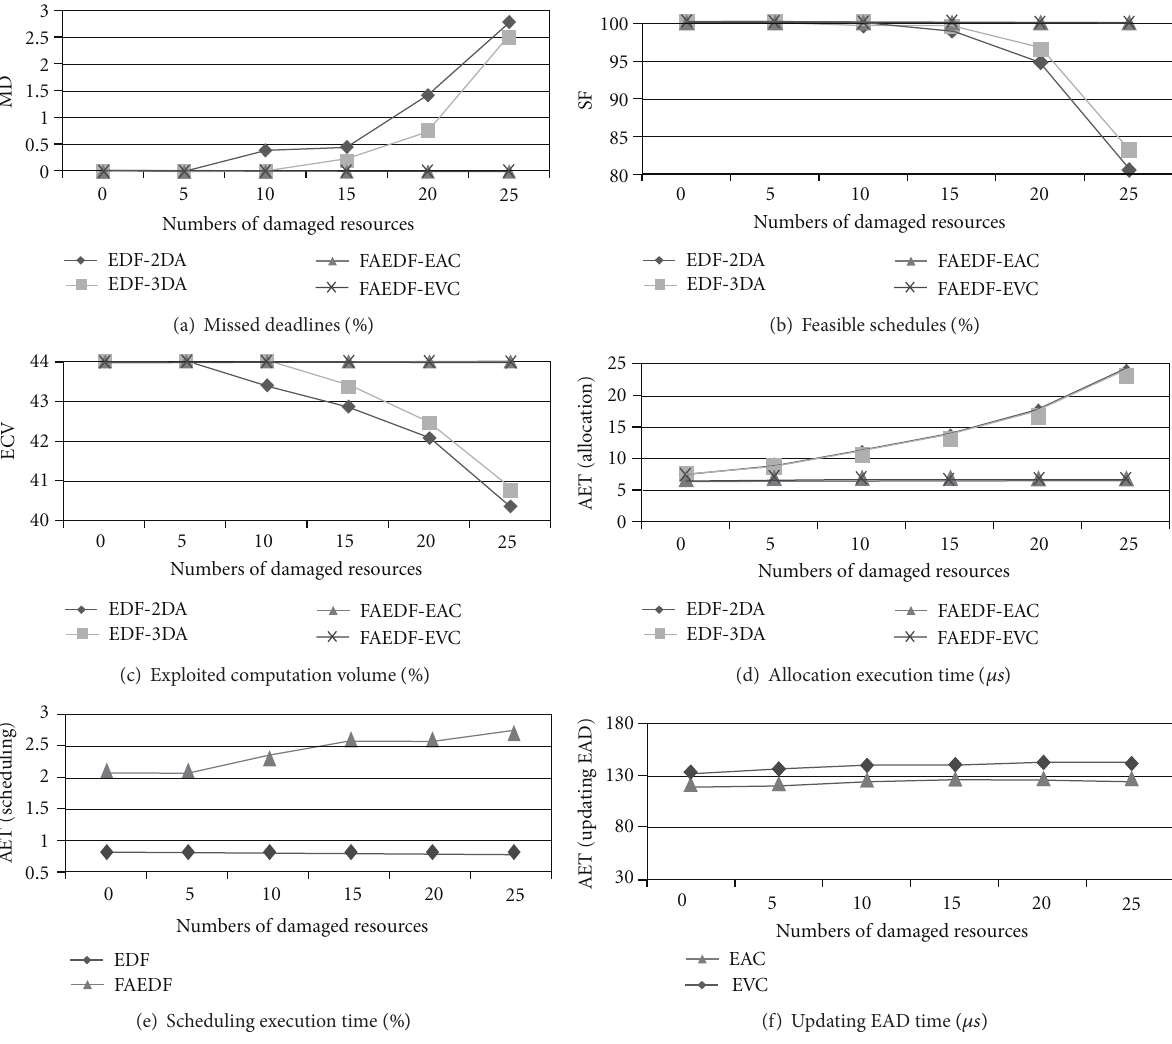
Figure 16: Low utilization of the FPGA and tight real-time requirements: 𝑈